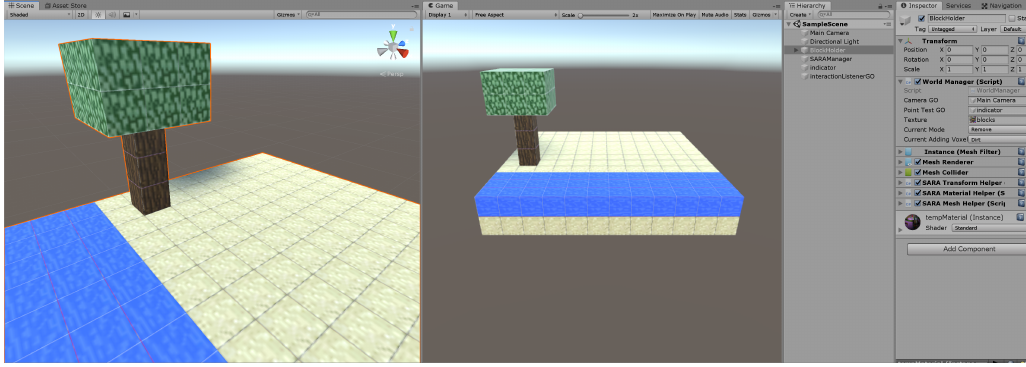
Figure 13. Screenshot of the Unity